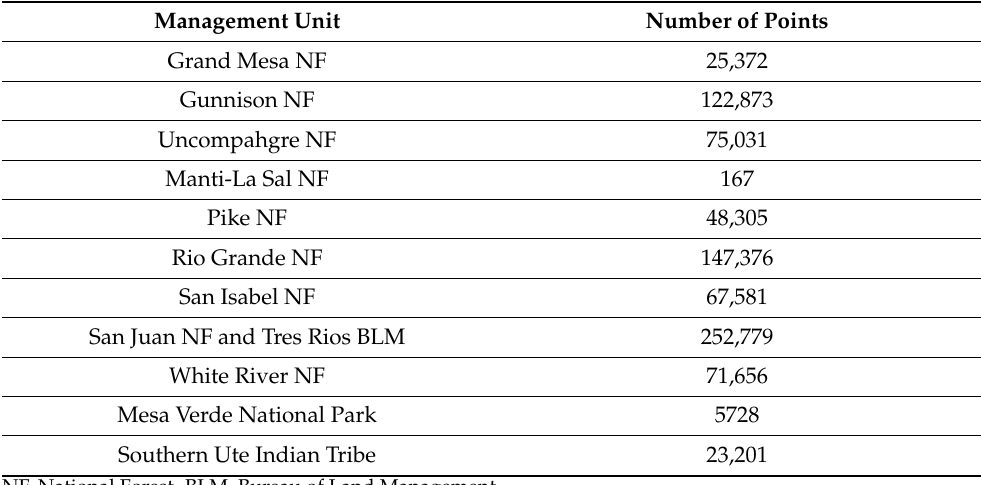
Table A1. Number of grid points sampling spatial vegetation data in each management unit, totaling